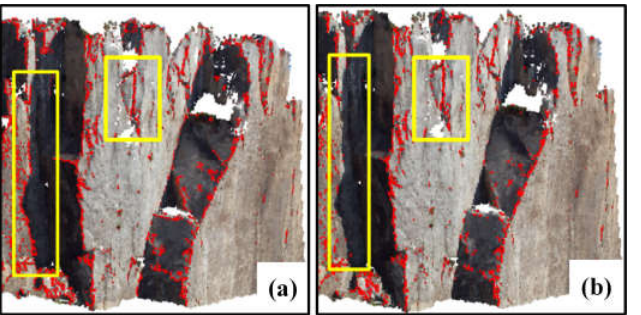
Finally, the redundant points among the potential discontinuity trace were removed with the MS-LBP model, as shown in Figure 11b.